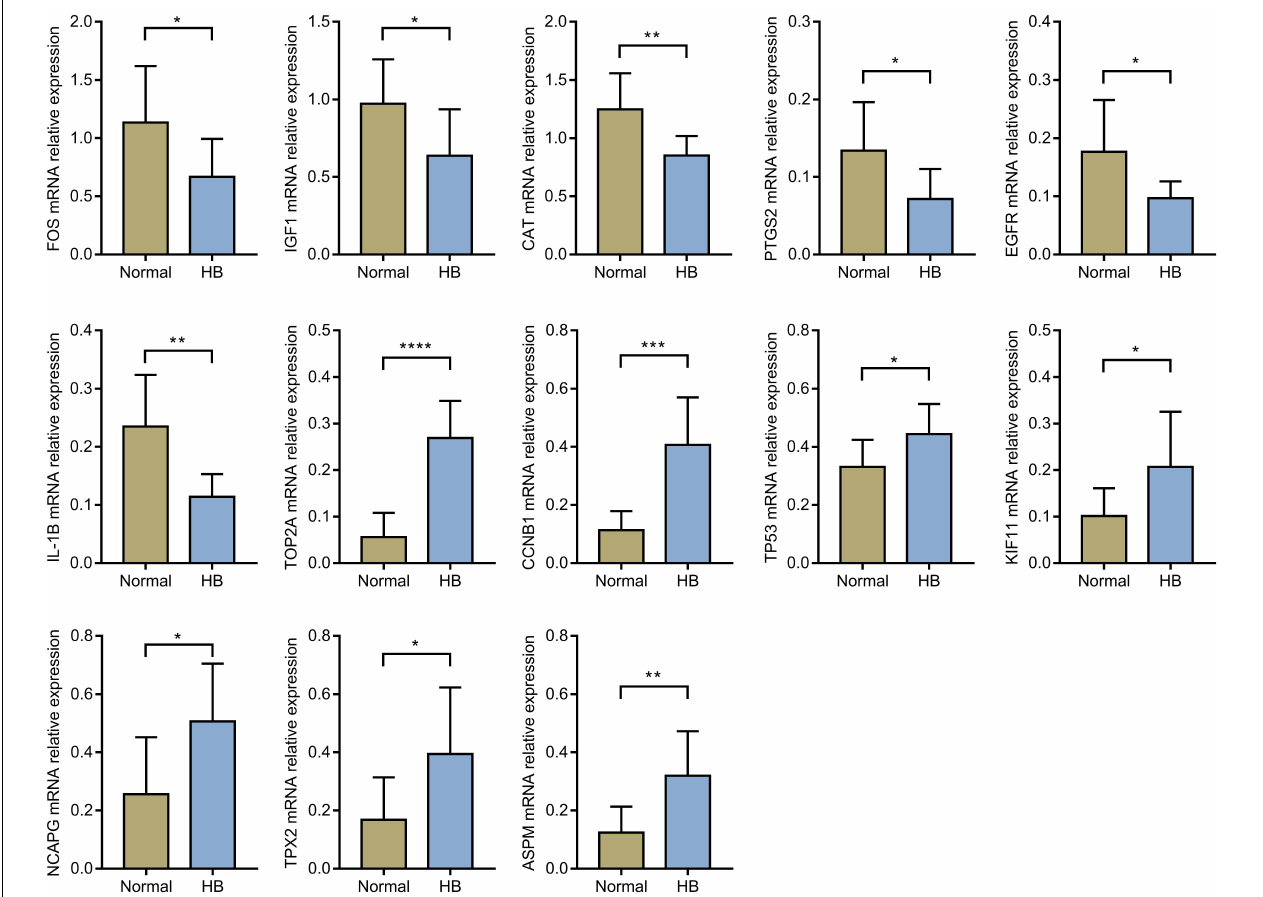
FIGURE 8 | The comparison of hub genes expression levels in HB and normal liver tissues in eight children with HB from our hospital. HB, hepatoblastoma. * P value < 0.05; ** P value < 0.01; *** P value < 0.001; **** P value <